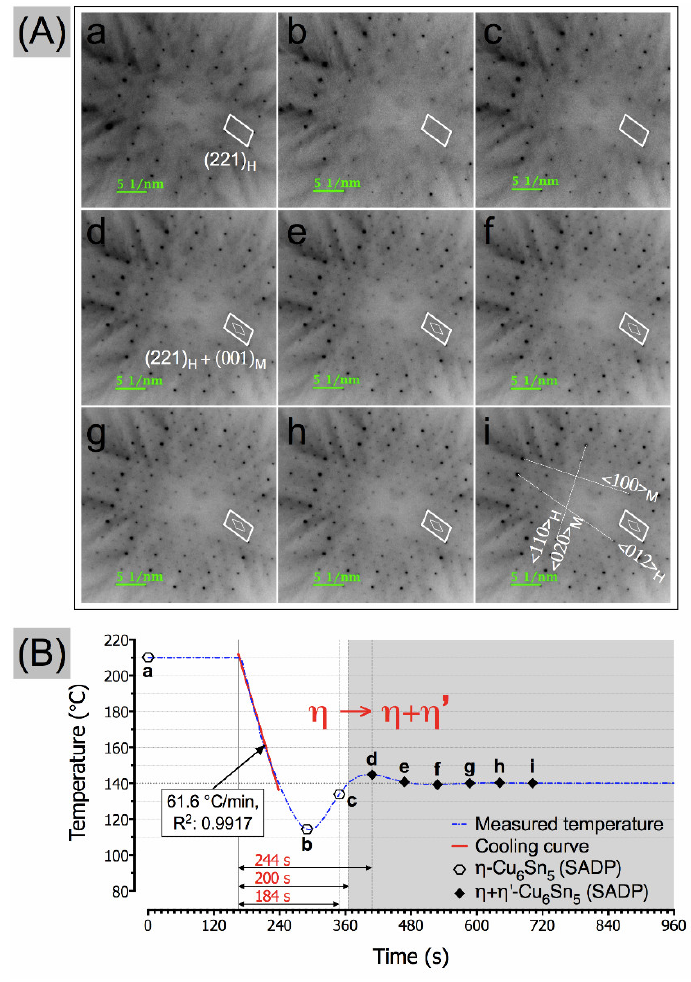
Figure 3. ( A ) Corresponding SADPs in the observed Cu 6 Sn 5 grain from time point-a to -i in the ( B ) profile temperature of the in-situ HV-TEM observations in diffraction mode. ( B ) profile temperature of the in-situ HV-TEM observations in diffraction